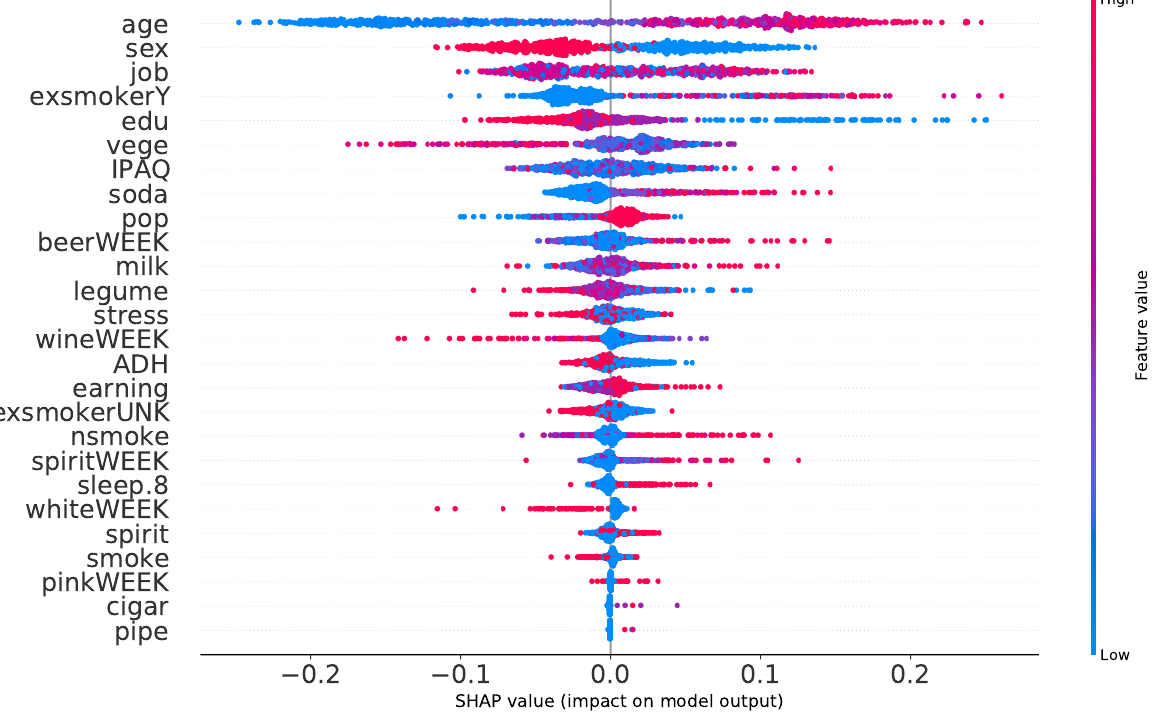
Figure 7. Impact of variables with SHAP, Random Forest without pathologies, and no